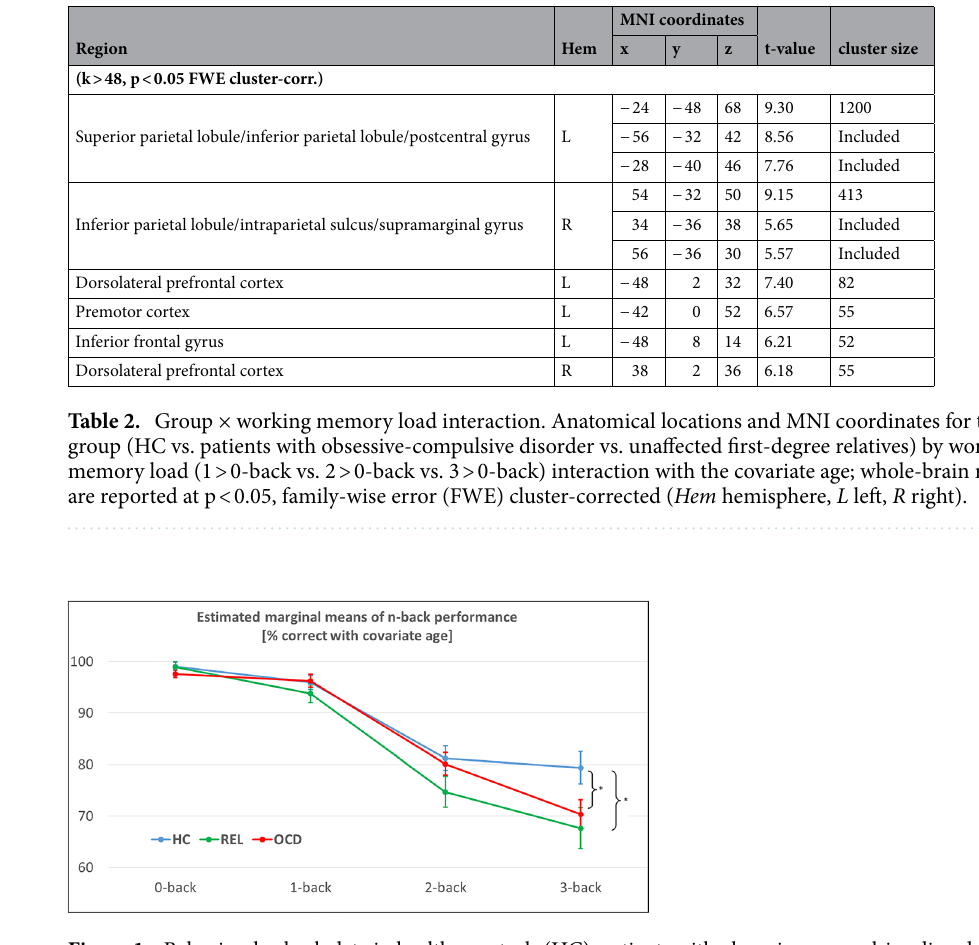
Figure 1. Behavioral n-back data in healthy controls (HC), patients with obsessive-compulsive disorder (OCD), and unaffected first-degree relatives of OCD patients (REL). Estimated marginal means are reported for performance [% correct] and are derived from the group (OCD vs. REL vs. HC) by working memory load (0- vs. 1- vs. 2- vs. 3-back) ANCOVA model with the covariate age. Error bars reflect standard errors of the mean. *p <